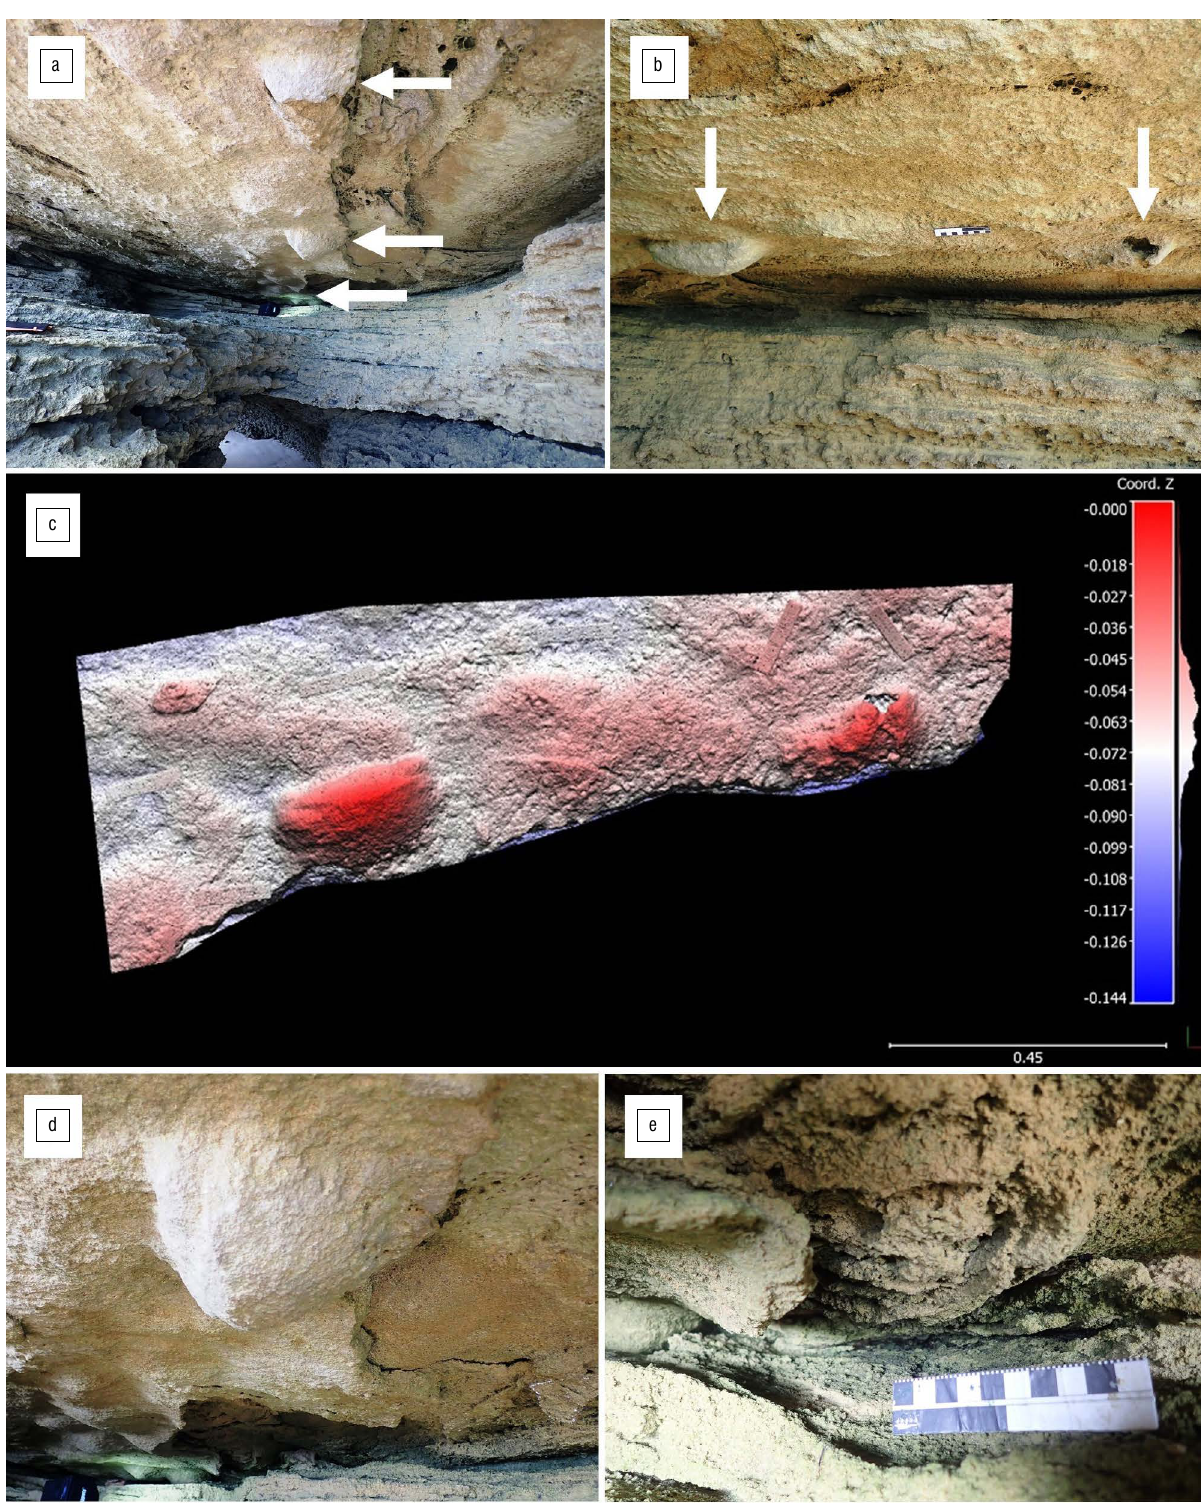
(a) Tracks in putative trackway are indicated with arrows, demonstrating narrow straddle: the top arrow points to Track C, the middle arrow points to Track B, and the bottom arrow points to Track A. (b) Tracks B (left) and C (right) are indicated with arrows; Track B is deeper in its anterior (seaward) portion; scale bar = 10 cm. (c) Photogrammetry colour mesh of Tracks B and C at Site 1, using 131 images. Track F is also visible, at top left. Photos were taken an average of 46.3 cm from the surface. The reprojection error is 0.488 pix. Vertical and horizontal scales are in metres. (d) Track B is steeper on its western (left in this photograph) aspect than its eastern aspect. (e) Track D; scale bar = 10